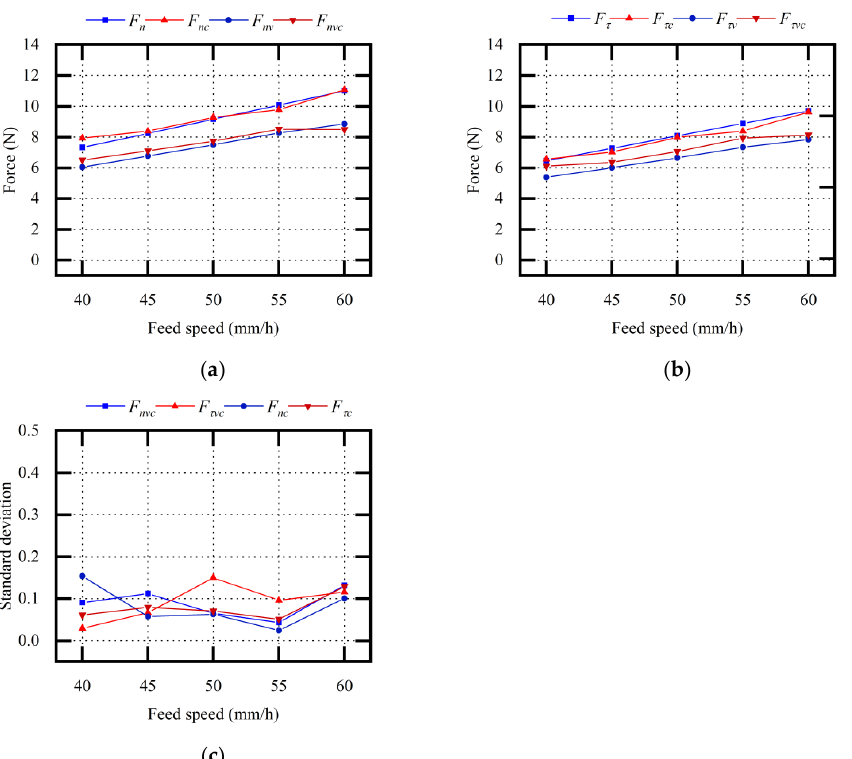
Figure 10. Comparative analysis of sawing force (variable v n ): ( a ) normal sawing force; ( b ) tangential sawing force; ( c ) standard deviation σ 1 of experimental values.